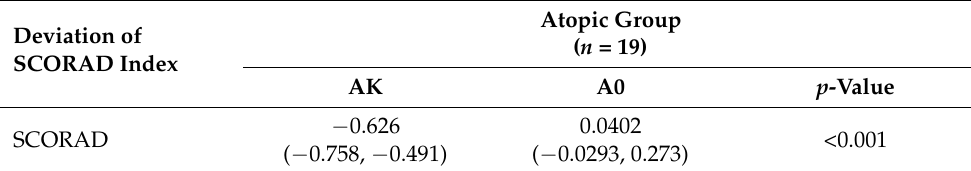
Table 5. Comparison of SCORAD Index variation, between kefir intake and control, for atopic group, after intervention (median (Q1,